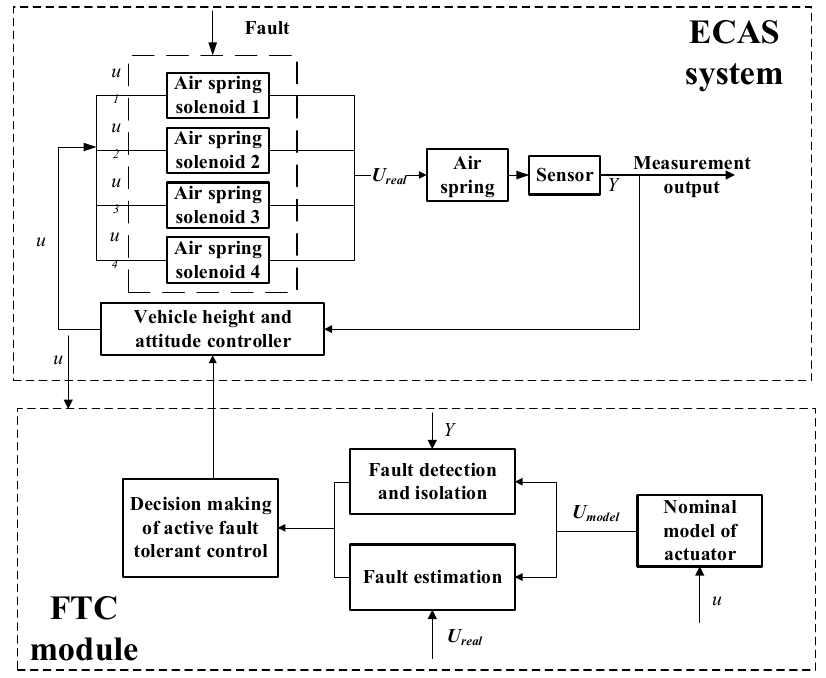
Table 4. Contents of active fault tolerant control decision module.